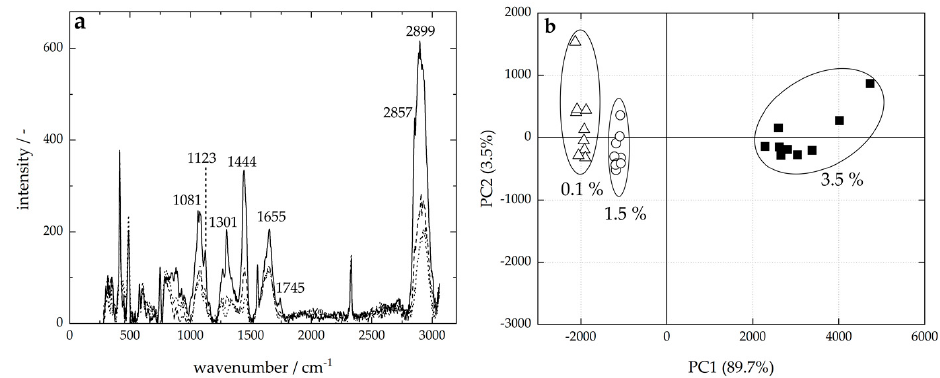
Figure 2a. They were smoothed using a Savitzky–Golay filter (interval: 10 and polynomial order: 3) for better peak visualization in the graph.